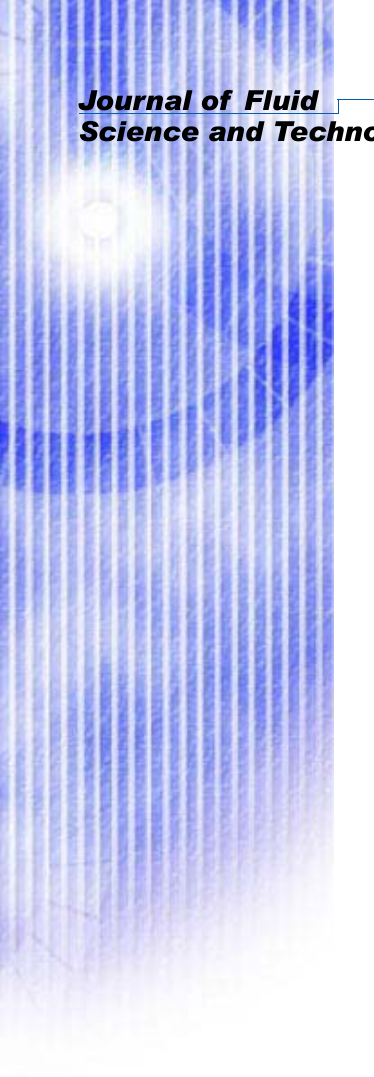
Fig.2 Blade design and configuration. (a) Side view and (b) top view of 3 flat blades. (c) Side view and (d) top view of 3 beveled